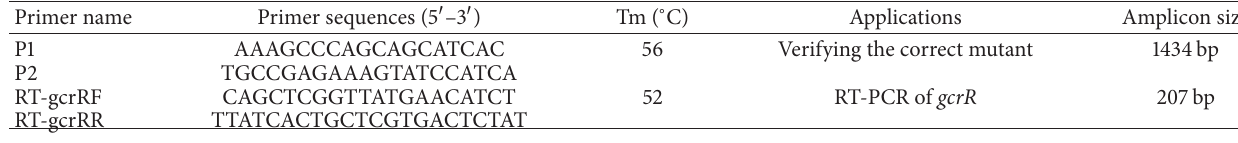
Table 1: Primers used in identification of the combination.